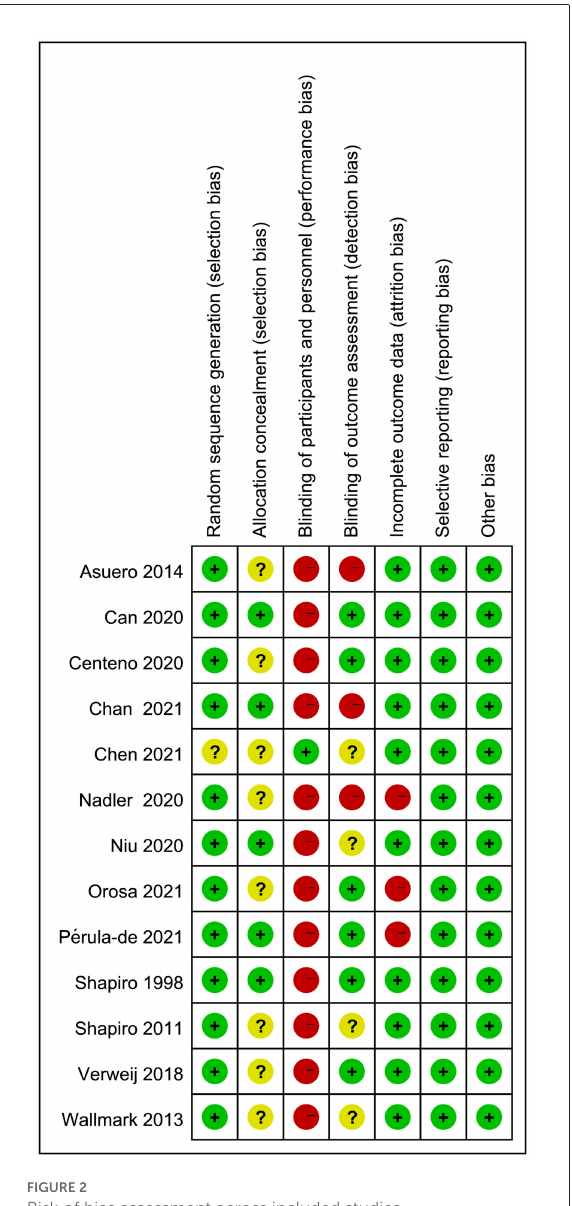
FIGURE2 Risk of bias assessment across included